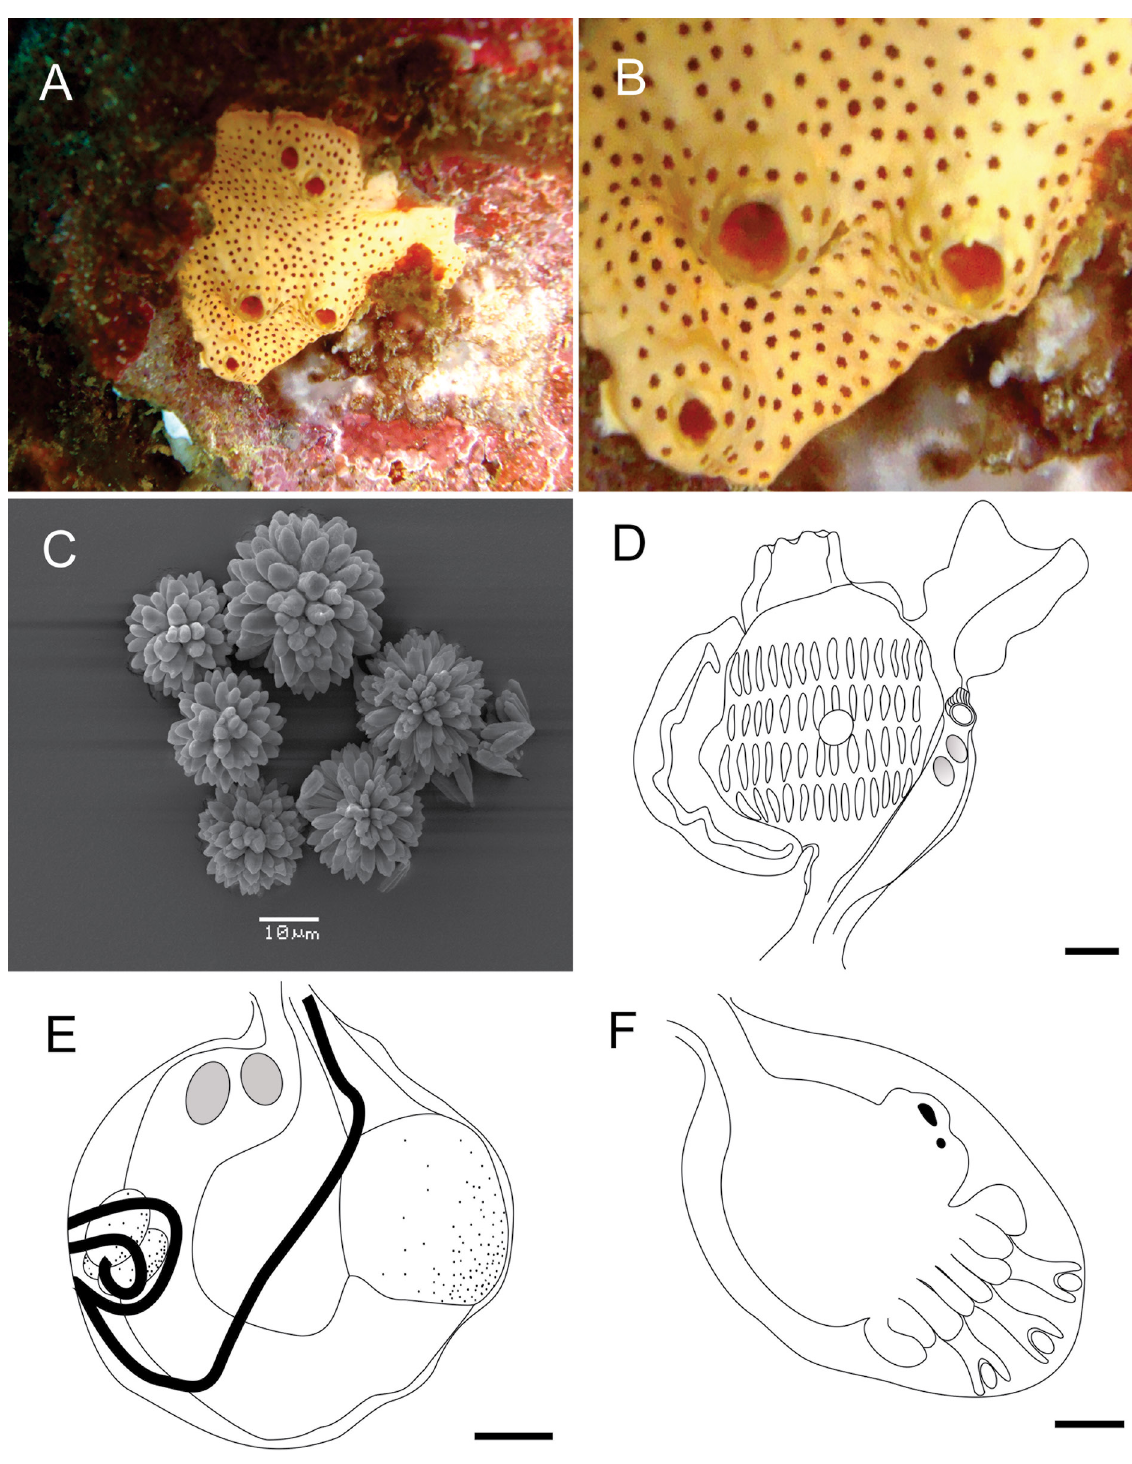
Fig. 2. Leptoclinides latus F. Monniot, 1983 (DZUP LEP-008). A . Colony in situ . B . Surface detail indicating lobed oral siphons and smooth cloacae. C . Spicules. D . Thorax. E . Abdomen. F . Larva. Scale bars: D–F = 0.1